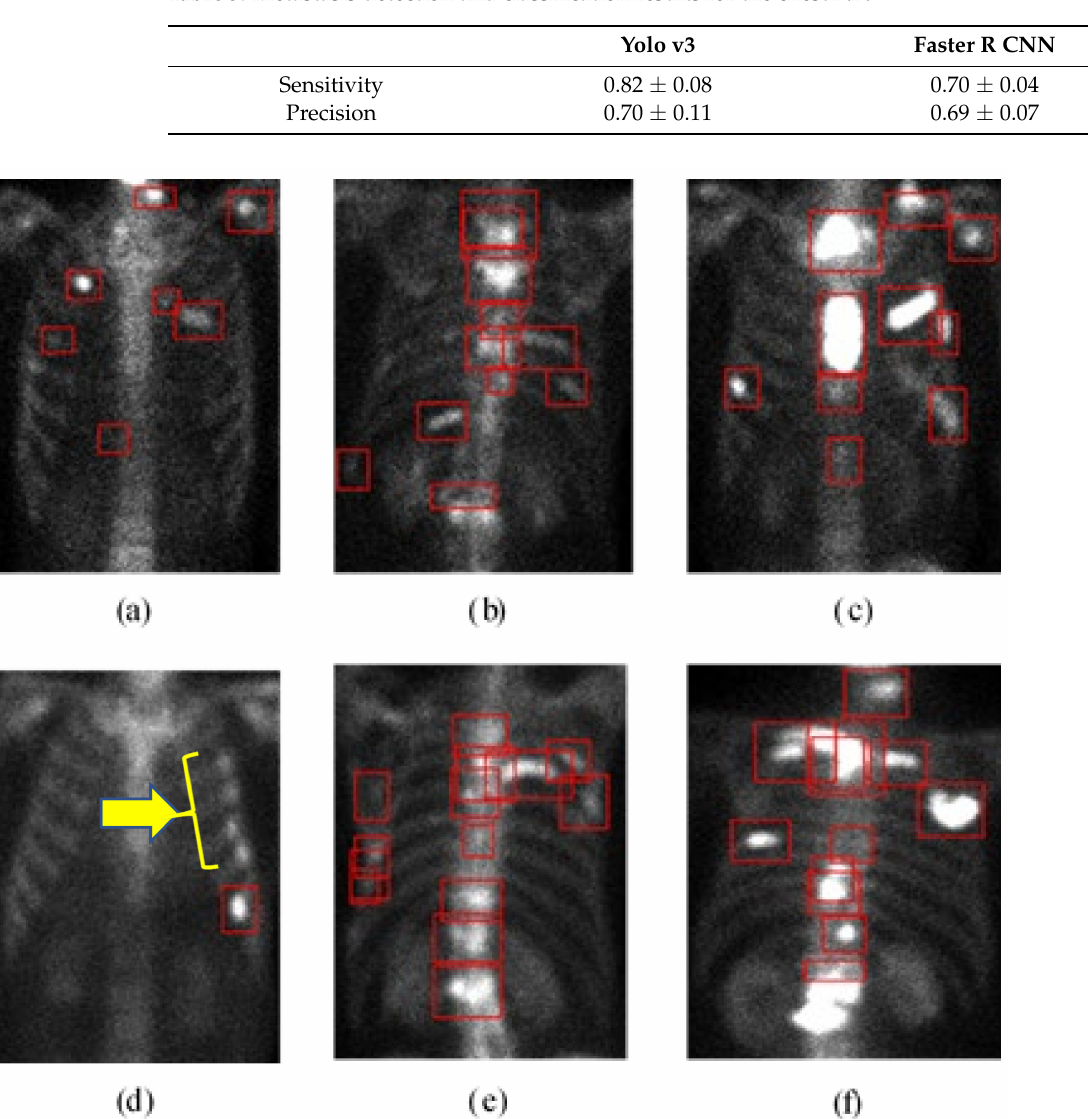
Table 3. Metastasis detection and classification results for the chest NN.